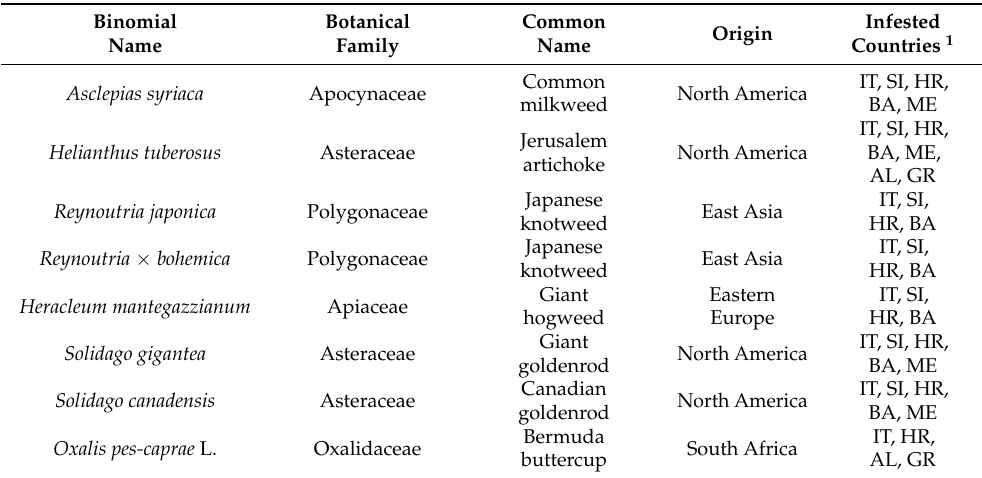
Table 1. Summary of the presence of the selected alien plant species in the countries of the Adriatic- Ionian